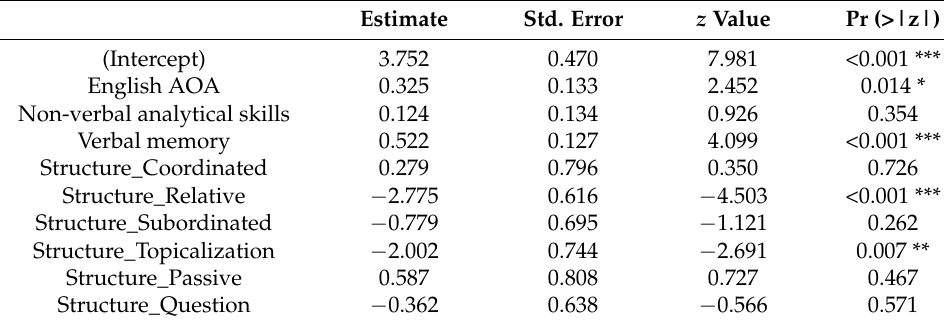
Table A10. Syrian Arabic T1 fixed effects.